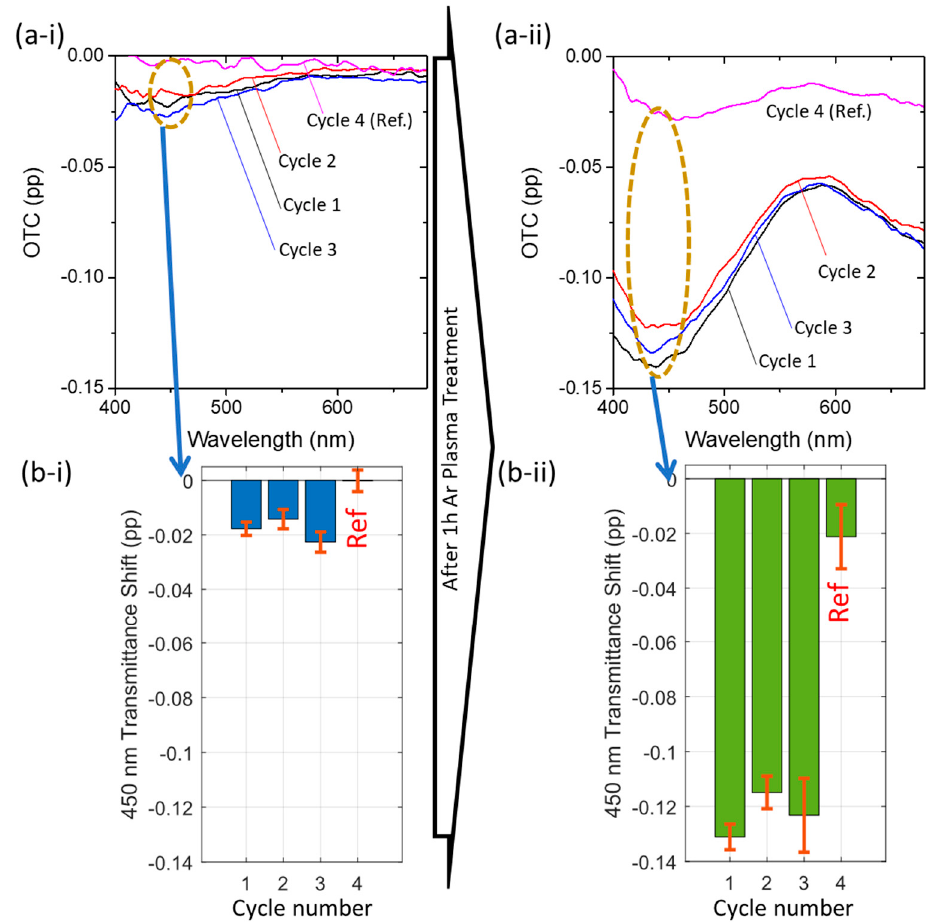
Figure 5. ( a ) Optical transmittance change of the full spectra and ( b ) transmittance shift at 450 nm, between dry-air and ethanol atmospheres, before ( a-i , b-i ) and after ( a-ii , b-ii ) plasma treatment. The transmittance shift at 450 nm was estimated to increase from 0.018 pp to 0.123 pp, a seven-fold increase.